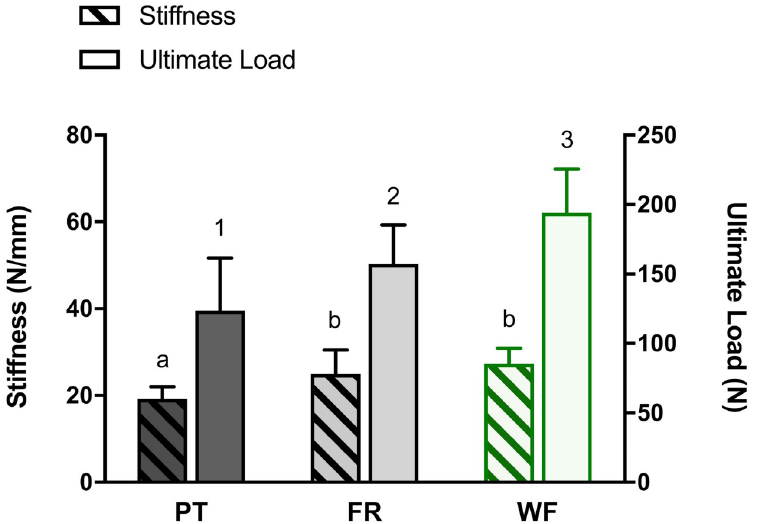
Fig 4. Effects of suture techniques Pulvertaft (PT), Fride ´ n (FR) and Woven-Fride ´ n (WF) on stiffness (resistance of sutures to deformation) in N/mm (crosshatched bars) and on ultimate load in N (single-colour bars). Data is expressed as means, standard deviation bars are shown. Different superscripts indicate statistically significant differences among groups at p < 0.05 and for WF vs. PT at p < 0.0001. For each experimental group, 12 side-to-side tenorrhaphies were